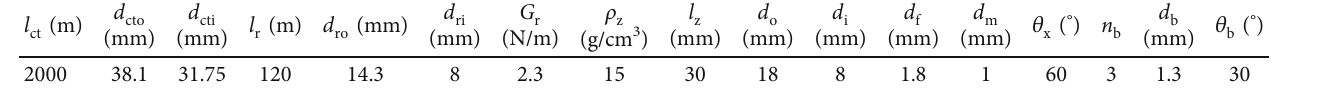
Table 2: Main parameters of the project.